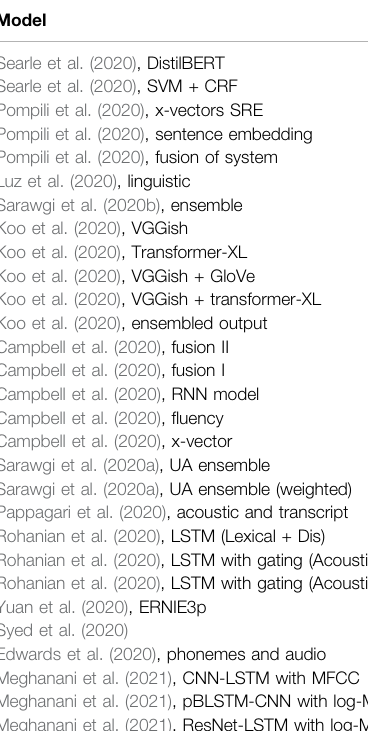
TABLE 1 | Baseline methods on ADReSS test